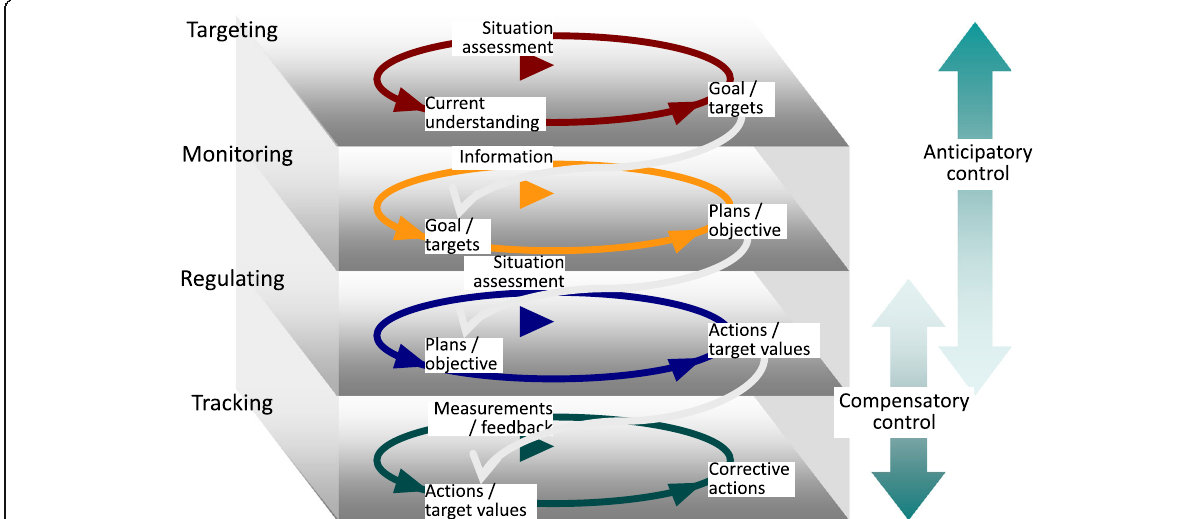
Fig. 1 The extended control model. Retrieved from http://erikhollnagel.com/ideas/ecom.html Copyright 2016 by Erik Hollnagel. Reproduced with